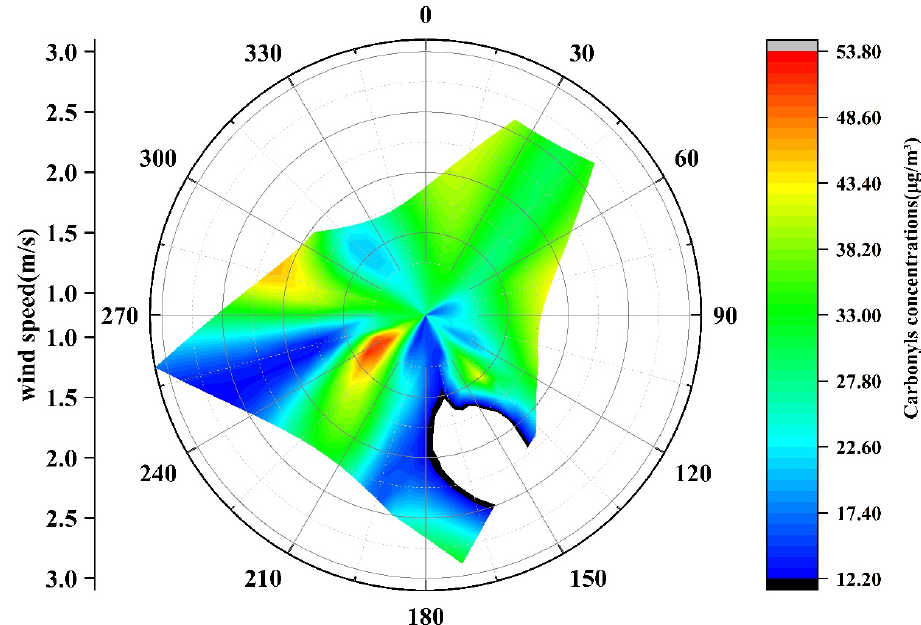
Figure A2. Diurnal variations of wind speed and boundary layer height in four seasons.